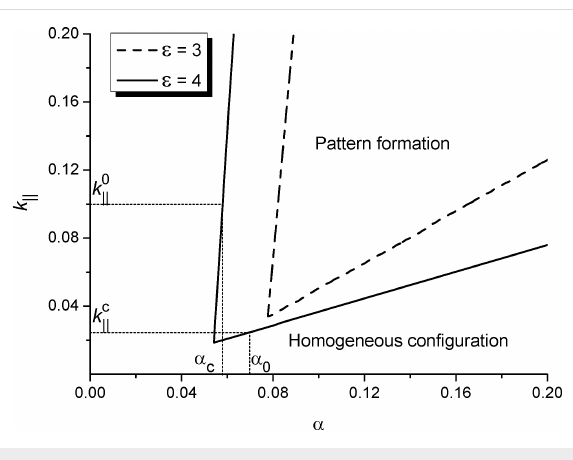
Figure 2: Stability diagram k ∥ ( α ) at different values of the interaction strength ε .